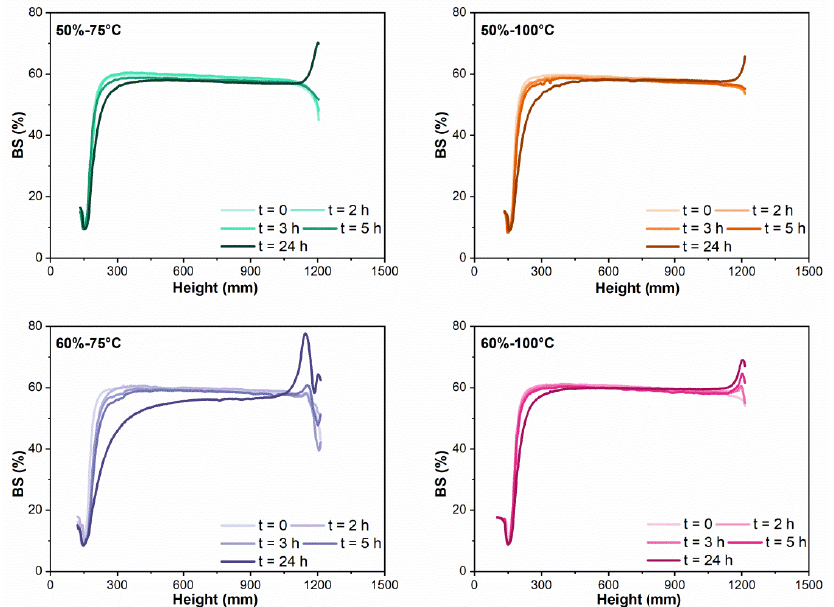
Figure 8. Backscattering (BS,%) profiles of the reconstituted IMF emulsions, after 0, 2, 3, 5, and 24 h of storage at 20 °C.